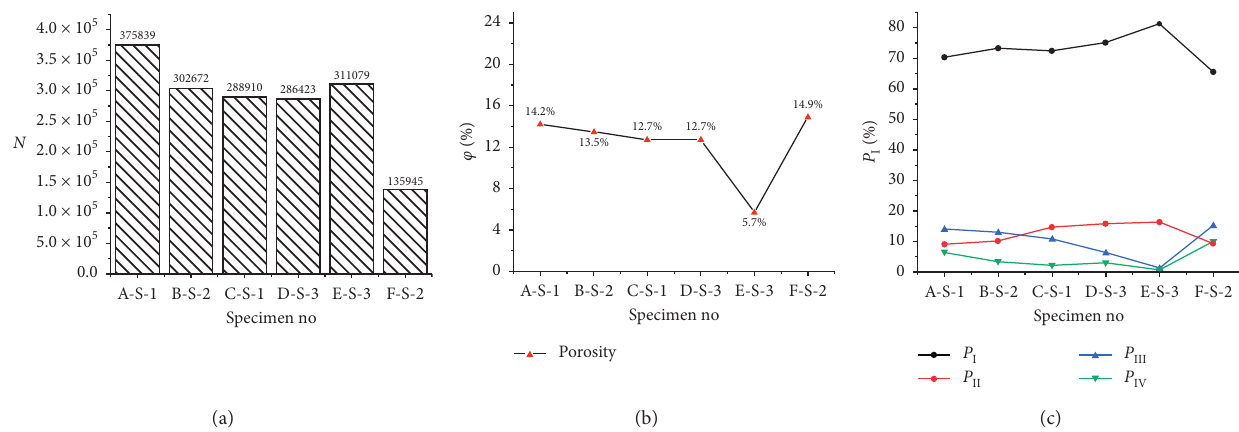
Figure 12: Statistical diagrams of sample microstructural parameters. (a) Number of pores in the samples. (b) Porosities of the samples. (c) Line graphs of P I , P II , P III , and P IV